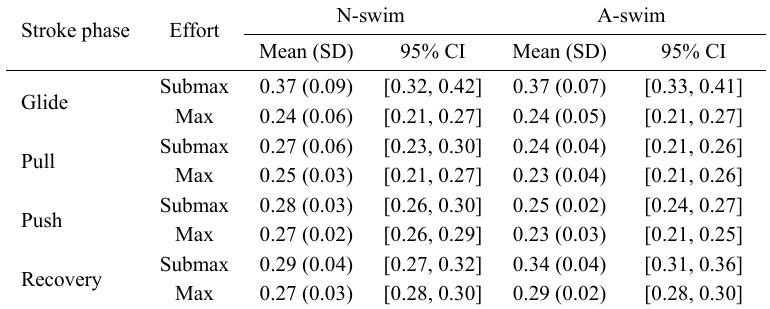
Fig. 2. Swimming velocity (m · s − 1 ). (A) stroke rate (Hz). (B) and stroke length (m). (C) in Submax and Max. Data are presented as mean ± SD. *, p < 0.05. Table 2. The duration of each stroke phase at Submax and Max (data are means ±